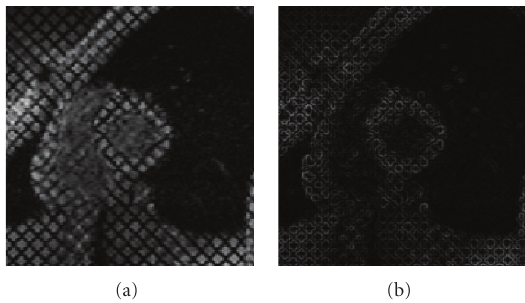
Figure 4: (a) Original image, (b) Norm of the corresponding gradient. As one can notice, the grid of tags does not allow us to obtain a good gradient attractor for myocardial